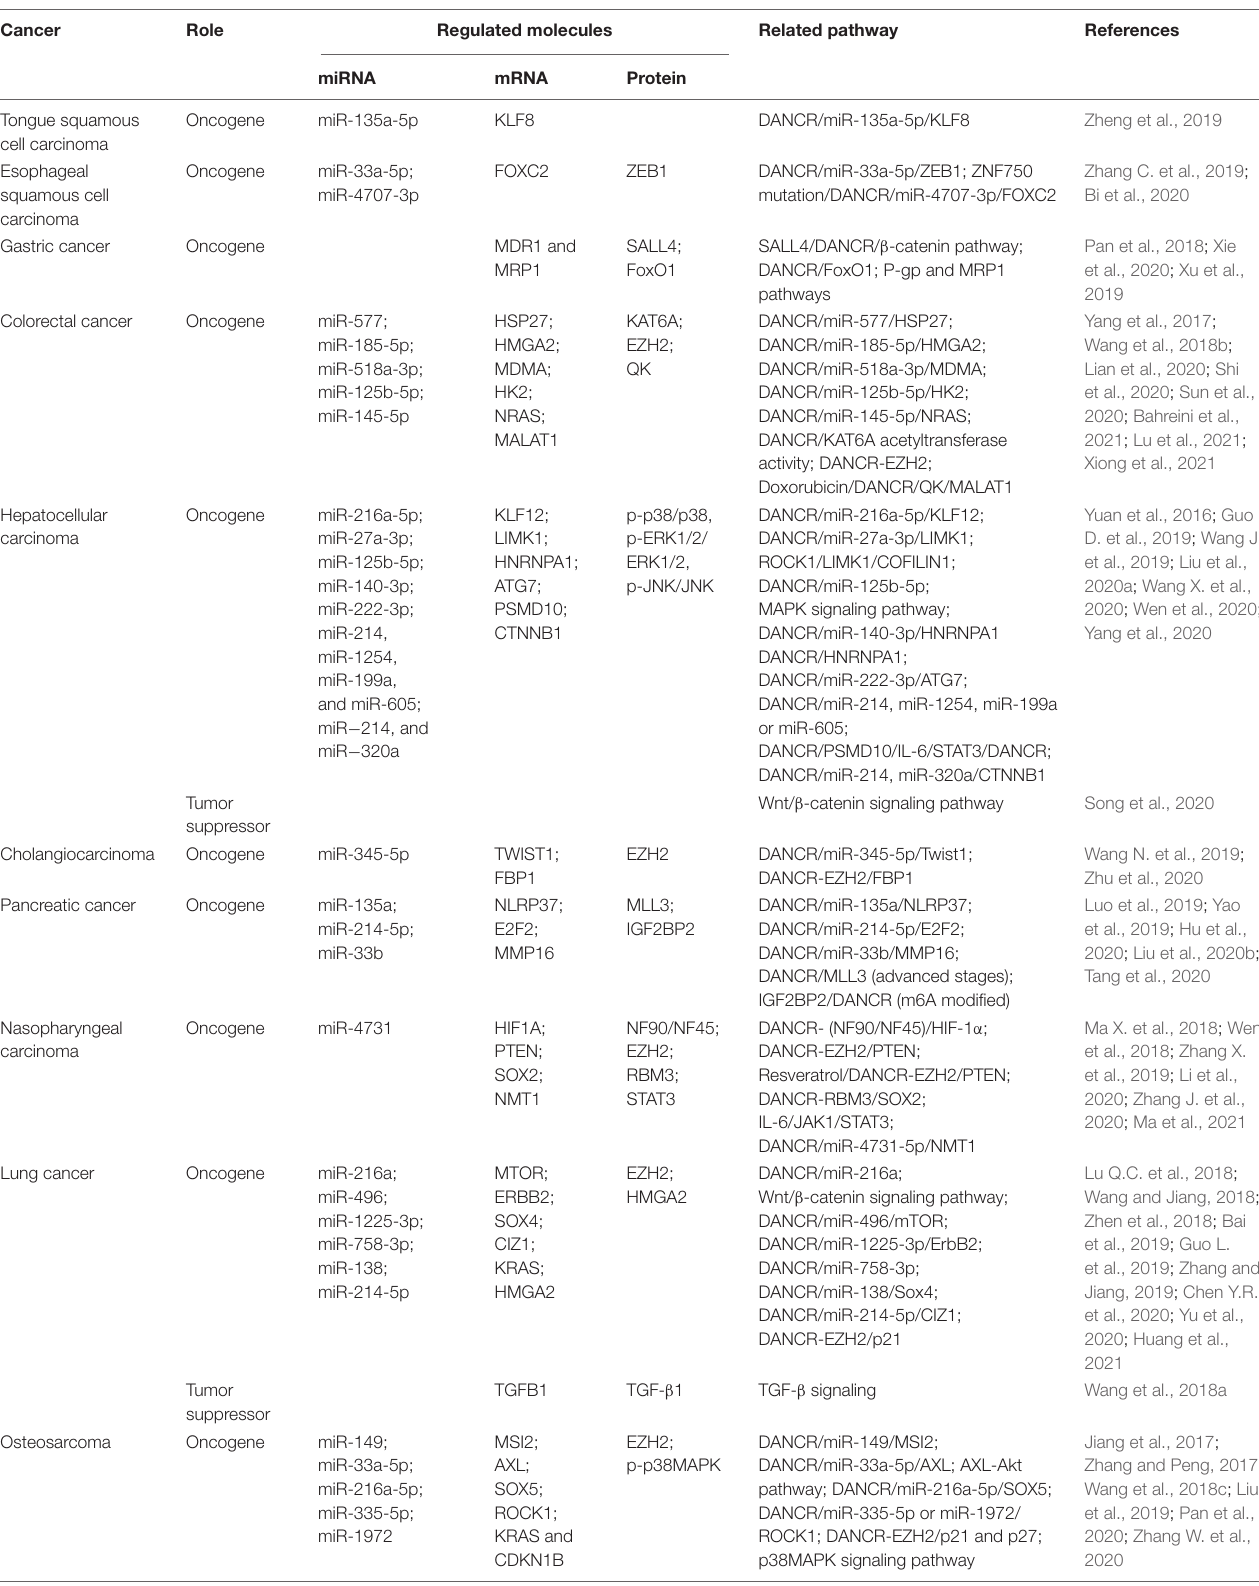
TABLE 1 | The molecular mechanisms of DANCR in various